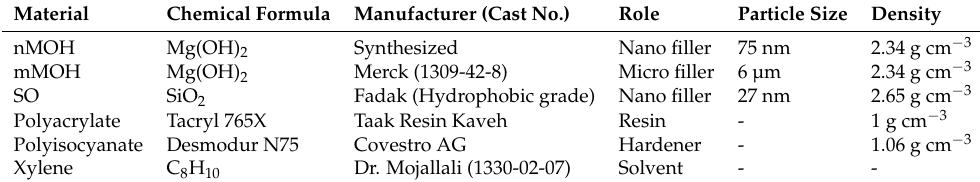
Table 1. Materials used for PU/Mg(OH) 2 fabrication.